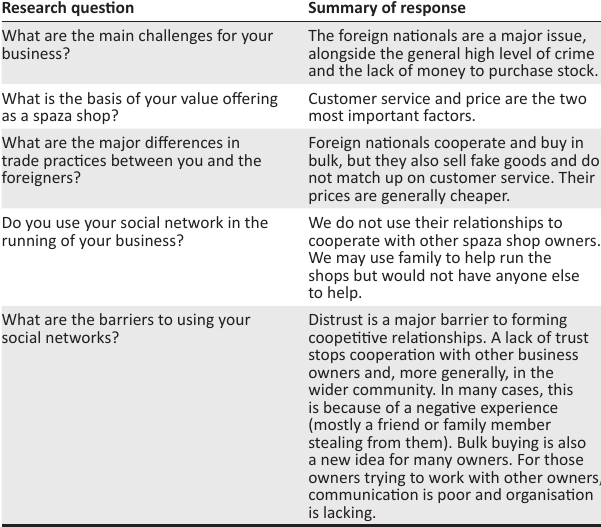
TABLE 3: Summary of response to research